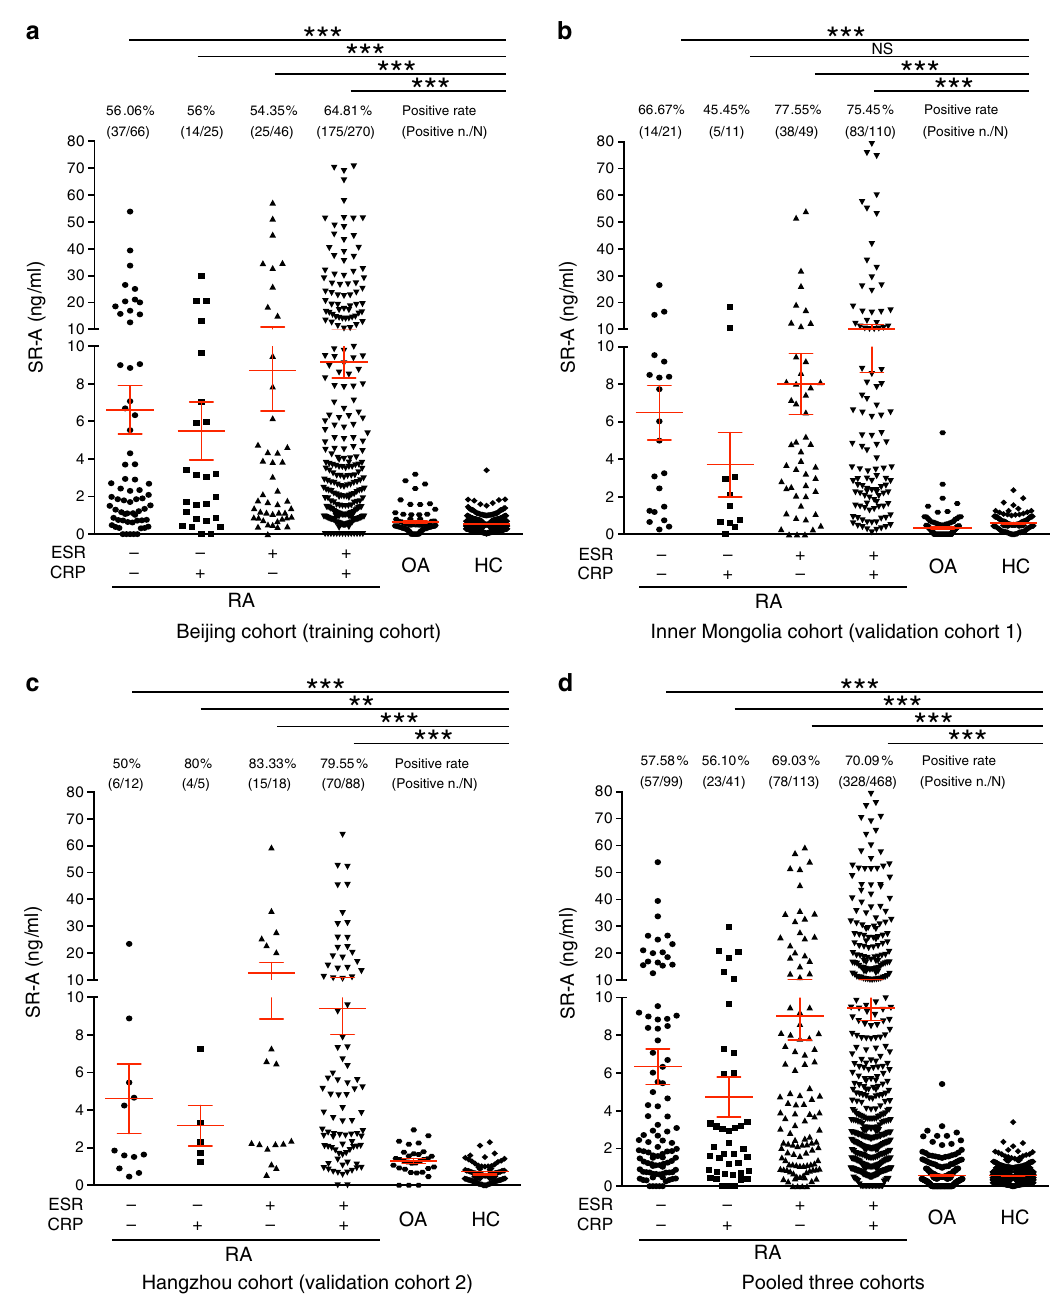
Fig. 4 sSR-A in RA patients with normal ESR and/or CRP. RA patients from the training and validation cohorts as well as the pooled cohort were divided into the following four groups, and the levels of sSR-A as well as the positive rates were further analyzed: RA patients with normal ESR ( − ) and normal CRP ( − ), RA patients with normal ESR ( − ) and increased CRP ( + ), RA patients with increased ESR ( + ) and normal CRP ( − ), RA patients with increased ESR ( + ) and increased CRP ( + ). a Beijing cohort: training cohort (*** p < 1E − 15, = 3.5748E − 07, <1E − 15, and <1E − 15, respectively, from left to right), b Inner Mongolia cohort: validation cohort 1 (*** p = 4.6610E − 06, = 6.7480E − 11, and <1E − 15, respectively, from left to right), c Hangzhou cohort: validation cohort 2 (** p = 0.0069, *** p = 1.6946E − 04, = 1.2122E − 10, and <1E − 15, respectively, from left to right), d Pooled three cohorts (*** p < 1E − 15, = 5.6245E − 10, <1E − 15, and <1E − 15, respectively, from left to right). n : the number of sSR-A-positive patients; N : the number of total patients. − : normal; + : increased. Red horizontal lines: means; error bars: SEMs. ** p < 0.01, *** p < 0.001, NS, not signi fi cant (Kruskal – Wallis test followed by Dunn ’ s posttest for multiple comparisons). Source data are provided as a Source Data fi